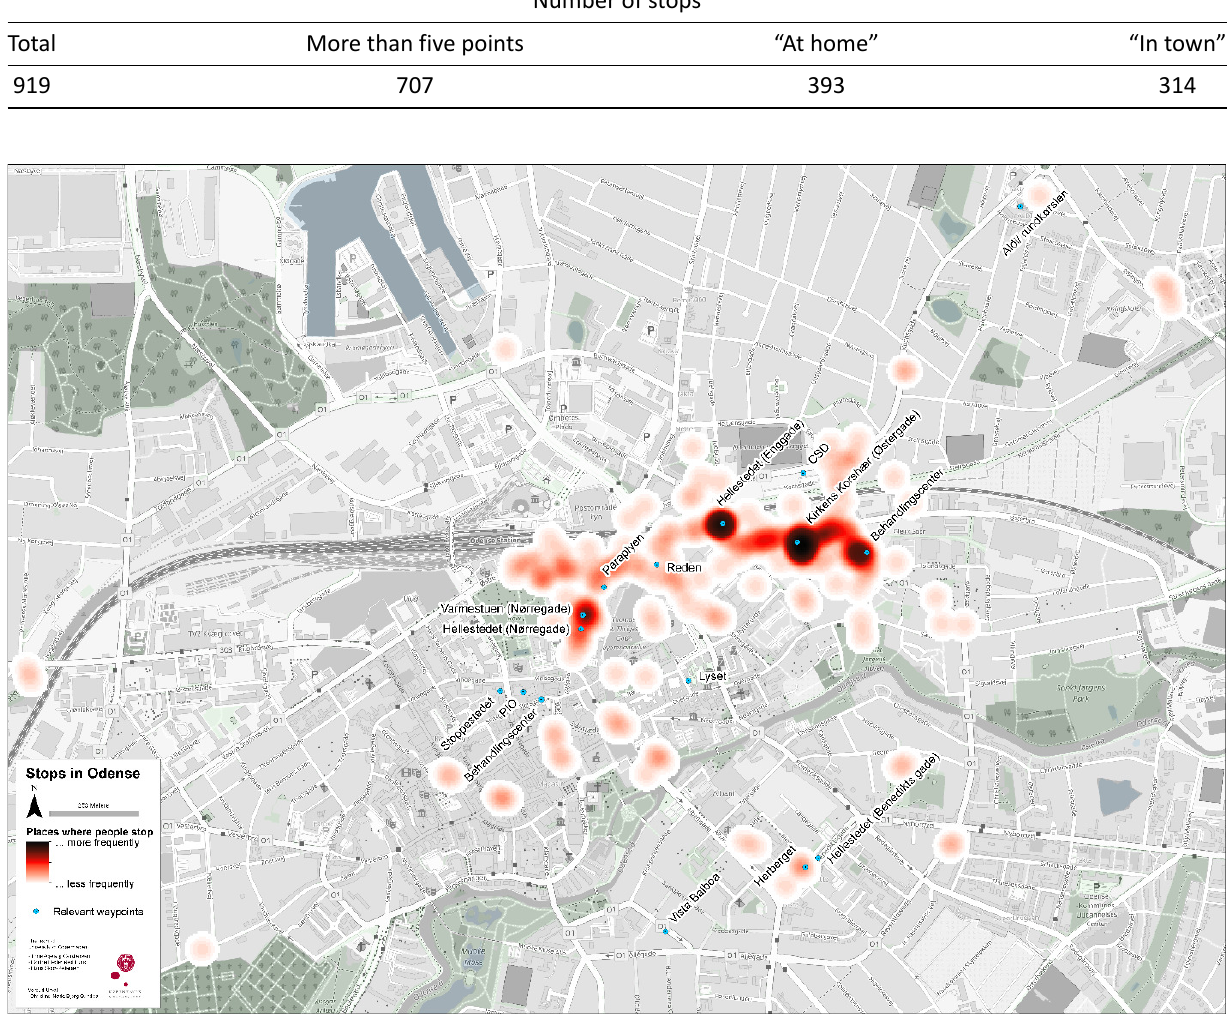
(Figure 1): http://joom.ag/af0L